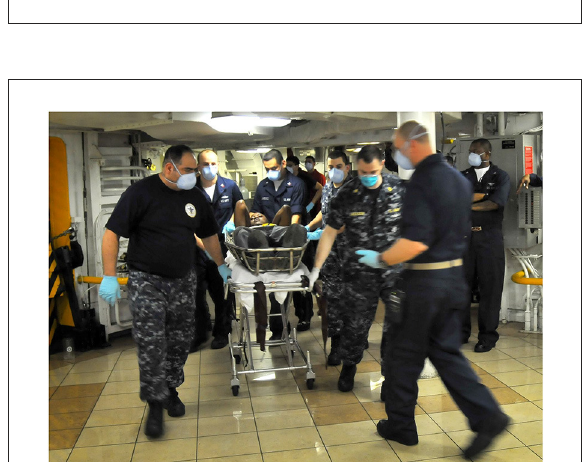
FIGURE5 A medical response team aboard the Nimitz-class aircraft carrier USS Carl Vinson (CVN 70) transports a Haitian patient to an operating room after being flown aboard by helicopter. Carl Vinson and Carrier Air Wing 17 are conducting humanitarian and disaster relief operations as part of Operation Unified Response after a 7.0 magnitude earthquake caused severe damage near Port-au-Prince, Haiti, January 12, 2010 (U.S. Navy photo by Mass Communication Specialist 2nd Class Daniel Barker/Released). The appearance of U.S. DoD visual information does not imply or constitute DoD endorsement. Source: Public domain image, not in copyright. Available at: https://commons.wikimedia.org/wiki/File:USS_Carl_Vinson_